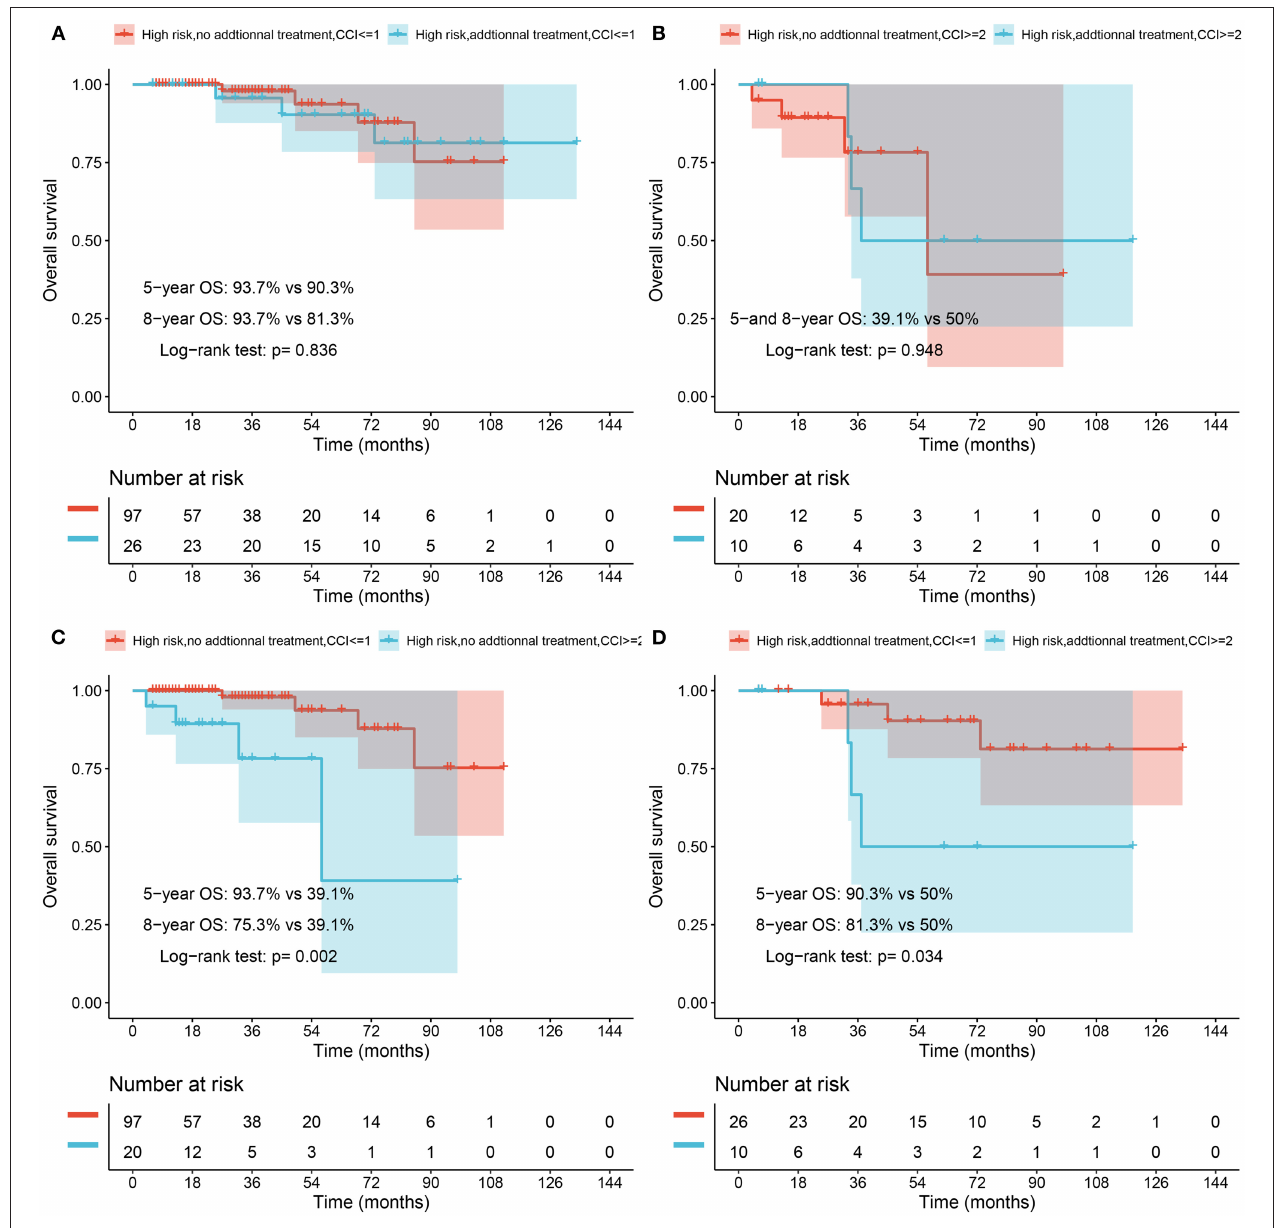
FIGURE 2 | (A) Overall survival rate of elderly EGAC patients with high risk and CCI ≤ 1 after ESD in no additional treatment and additional treatment groups. (B) Overall survival rate of elderly EGAC patients with high risk and CCI ≥ 2 after ESD in the follow-up and additional treatment groups. (C) Overall survival rate of elderly EGAC patients with high risk and no additional treatment after ESD in CCI ≤ 1 and CCI ≥ 2 groups. (D) Overall survival rate of elderly EGAC patients with high risk and receiving additional treatment after ESD in CCI ≤ 1 and CCI ≥ 2